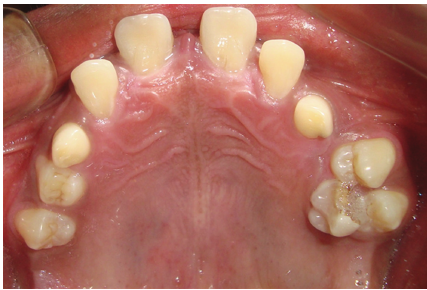
Figure 3: Intraoral photograph showing maxillary arch with retained deciduous teeth (Case 1).